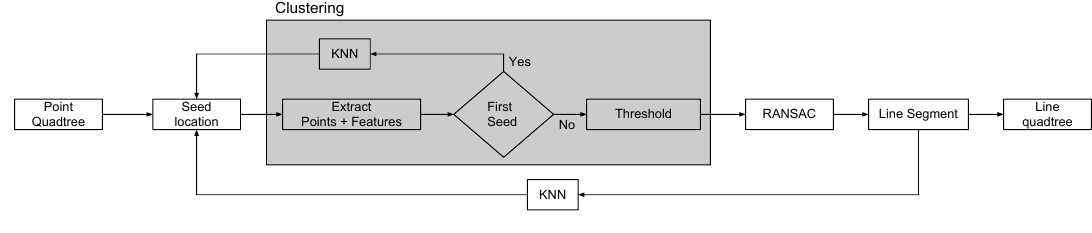
Figure 5. Region growing based line